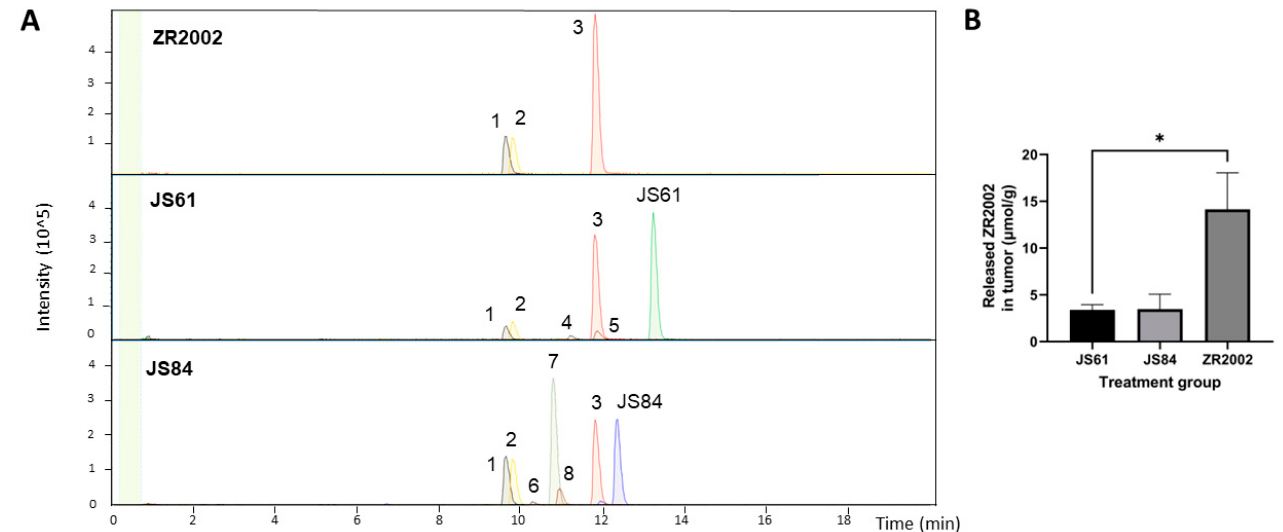
Figure 6. Main metabolites released in the tumors after 3 h from combi-molecule administration. ( A ) LC-MS chromatogram of the metabolization of ZR2002 (first row), JS61 (middle row) and JS84 (bottom row). Metabolites: (1) RB10, (2) RB10-N-Acetyl, (3) ZR2002, (4) JS61-OH-Cl, (5) JS61-OH-2Cl, (6) RB10-N-Acetyl-Methyl, (7) RB10-Methyl and (8) JS84-OH-Cl. The peak of JS61 intact drug is in green, while JS84’s is in blue, and the peak of ZR2002 is in red. ( B ) Quantification of ZR2002 released in the treated tumors (N = 4). Data are expressed as means ± SEM. * p < 0.05 between the two groups.